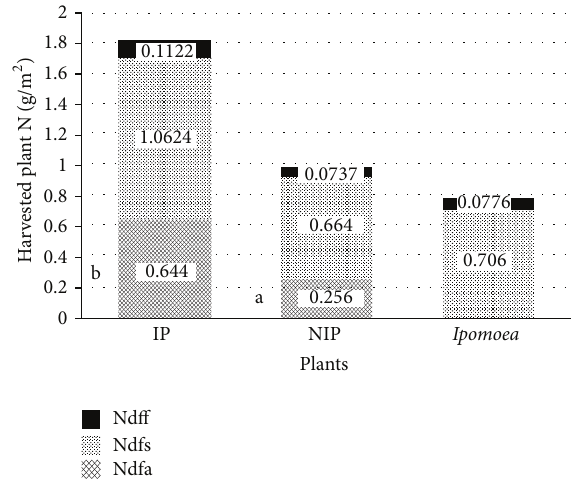
Figure2:SourcesandamountofplantN(g/m 2 )harvestedpertreat- ment during the four-month experiment period. Ndfs = nitrogen derivedfromsoil,Ndff=nitrogenderivedfromfertilizer,andNdfa = nitrogen derived from atmosphere. IP = inoculated Pueraria , NIP = noninoculated Pueraria . In a column, values correspond to the amount of N (g/m 2 ) per N source (soil, fertilizer, and atmosphere). One-way ANOVA using CropStat ver. 7.2 was applied to the same N source for IP, NIP, and Ipomoea and no significant difference was observed except for Ndfa between IP and NIP with different